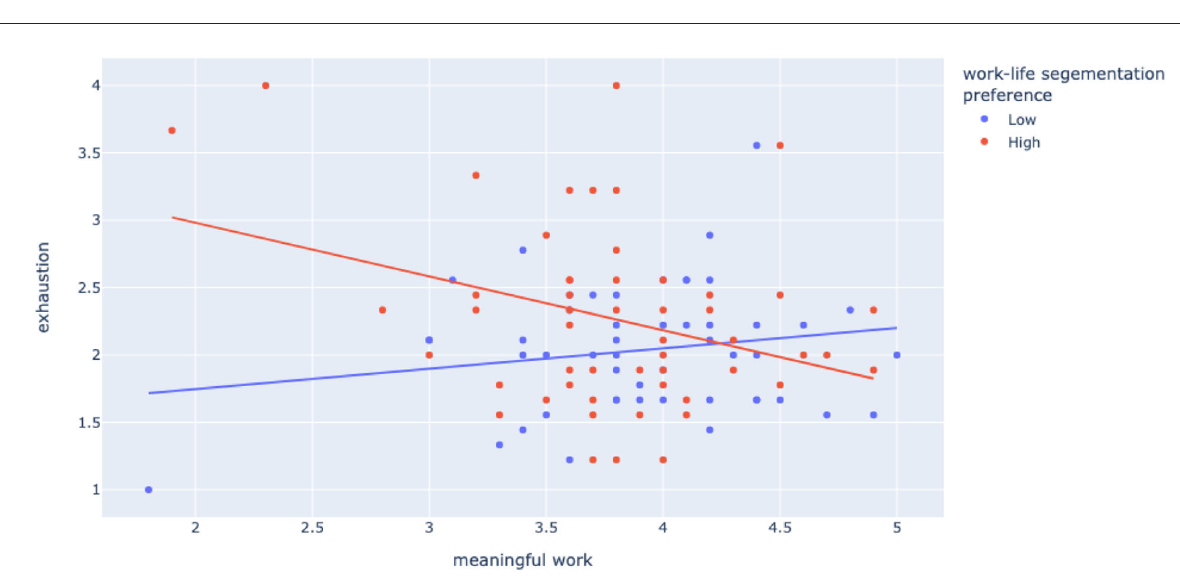
FIGURE2 Moderation meaningful work × exhaustion by work–life segmentation